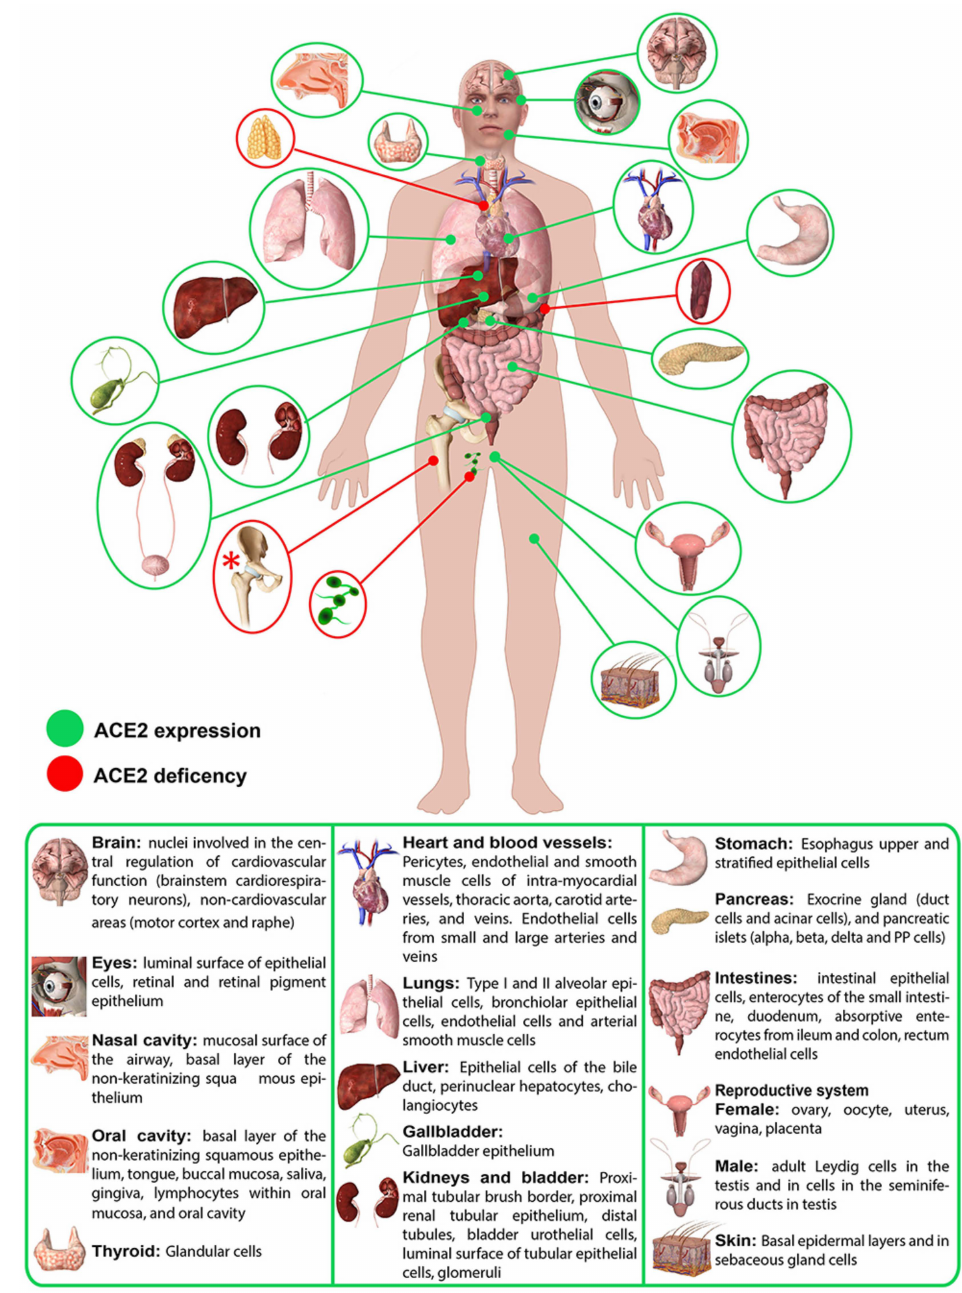
Figure 1. Schematic of the distribution of ACE2 in human organs; it is clear that the major organs that provide ACE2 are therefore all susceptible to SARS-CoV-2 infection. According to the WHO, many patients have been referred to hospitals complaining of pain in various organs following involvement with COVID-19. Reproduced with permission from [19]. Copyright Frontiers,